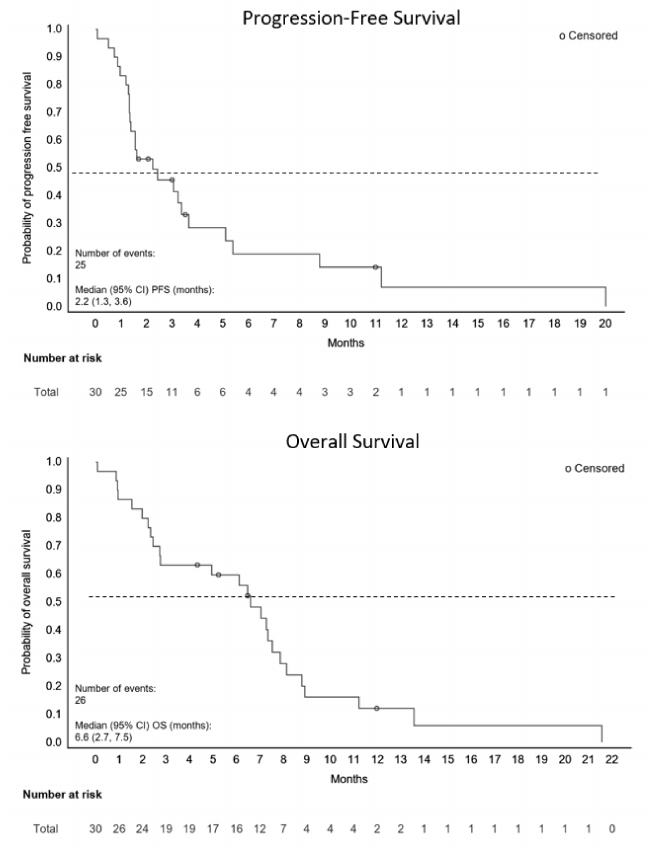
Figure 2. Progression-Free and Overall